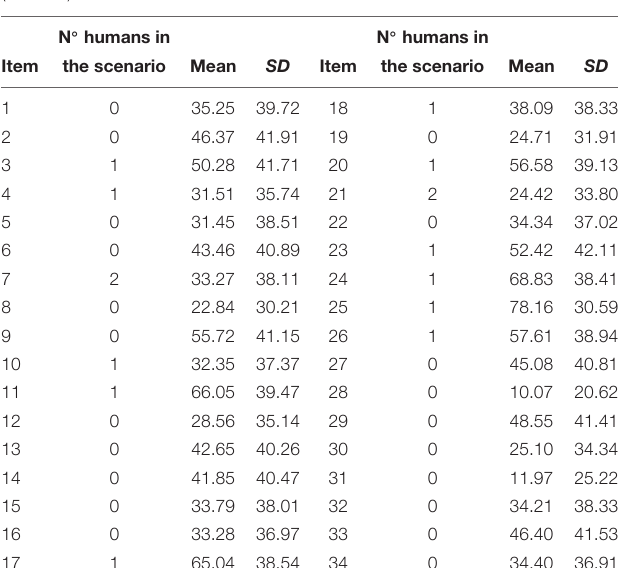
TABLE 2 | Average score and standard deviation for each item of the ISQ ( N = 106).